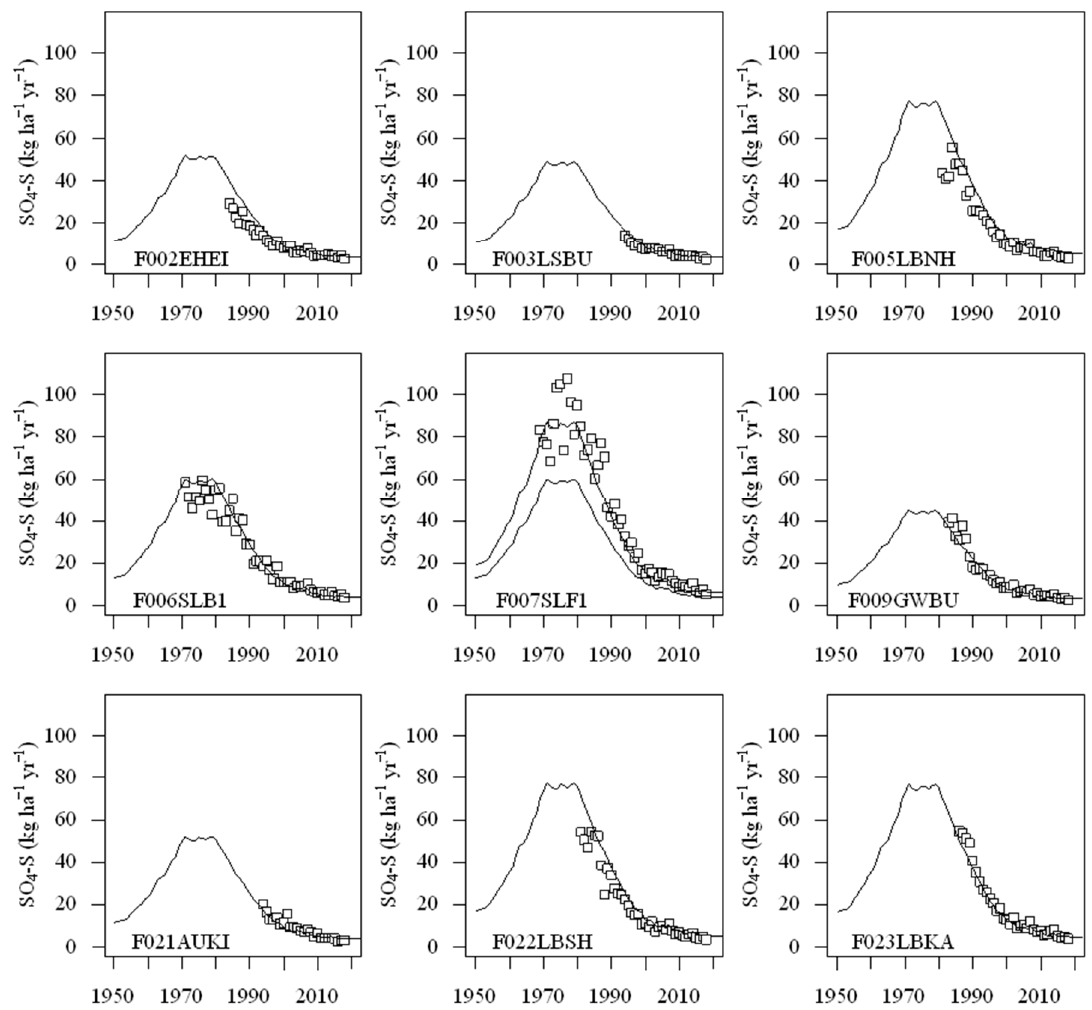
Figure 2. The time series of observed total sulfur deposition from throughfall measurements ( □ ) at permanent soil-monitoring plots and the reconstructed time series of sulfur deposition for the period 1950 to 2020. The dotted line shows a site-specific recalibration of the observed data for the F007SLF1 plot.